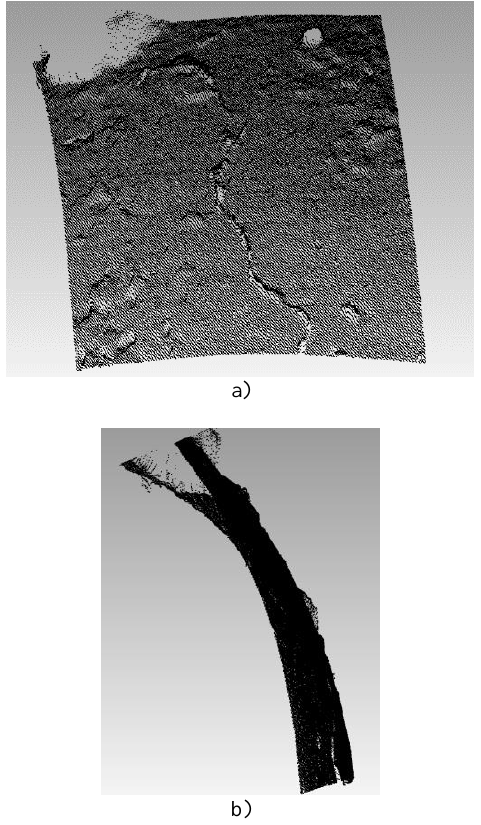
Figure 4. a) Part of one of the monument’s domes. The crack